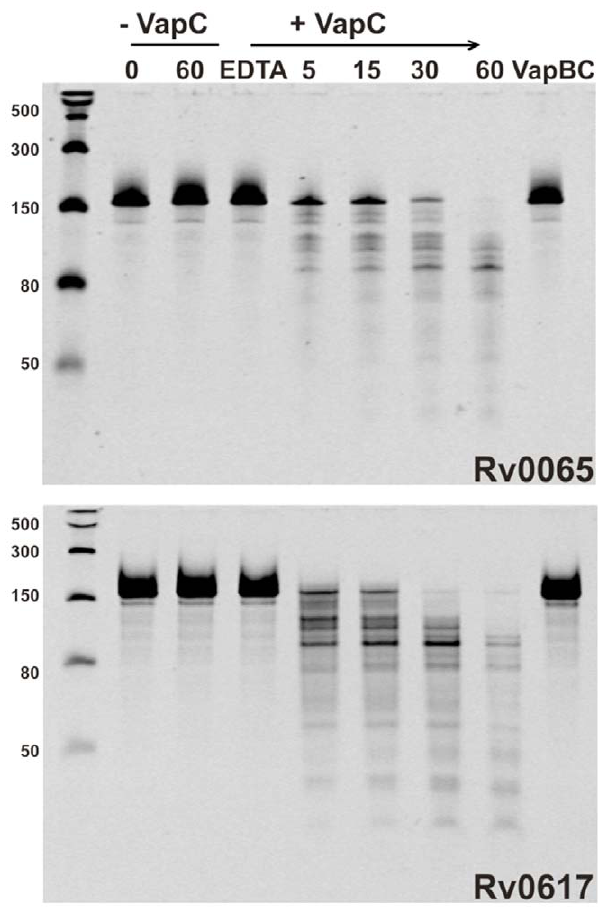
Figure 8. The VapCs Rv0065 and Rv0617 have RNase activity. VapC proteins Rv0065 and Rv0617 display sequence-selective RNase activity against an RNA substrate of , 150 bases in the presence of 6 mM MgCl 2 . Activity is Mg 2 + -dependent as addition of 12 mM EDTA abolishes activity (lane 4). Ribonuclease activity is also inhibited in the presence of VapB (lane 9). Addition of VapC ( + VapC) results in degradation of the RNA substrate over a period of 5 – 60 minutes (lanes 5–8). RNA only controls (-VapC) show no contaminating ribonuclease activity (lanes 2 & 3). The molecular weight marker shows molecular masses of single-stranded RNA in number of bases (lane